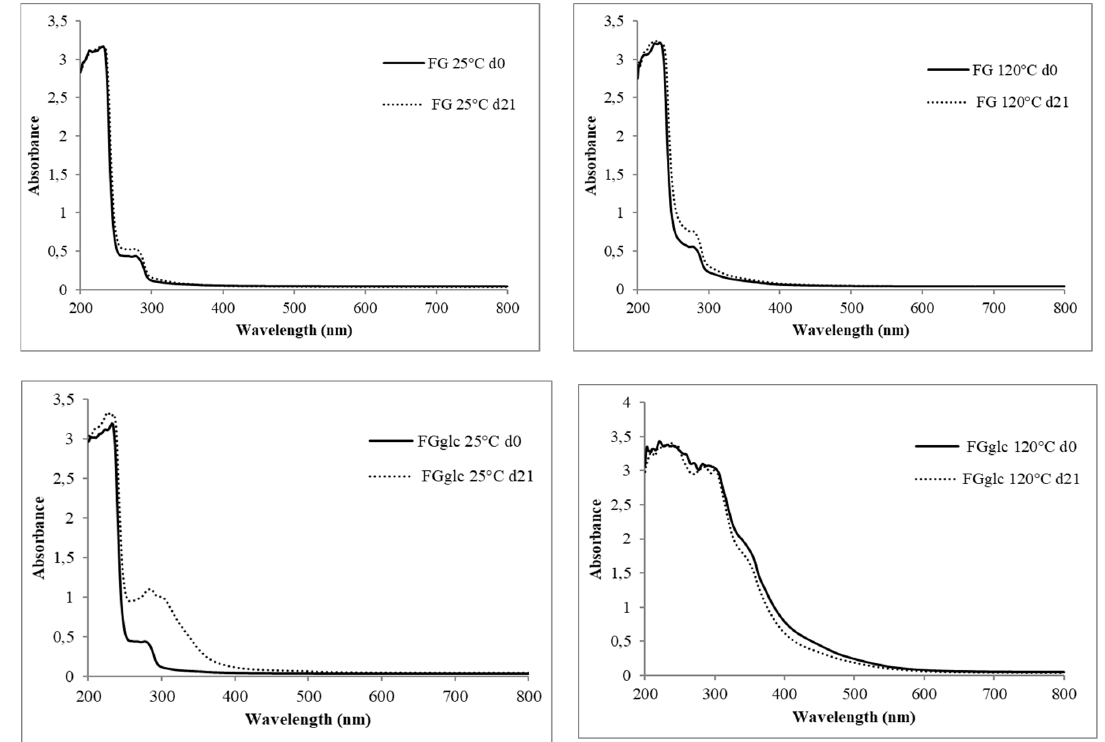
Figure 6. UV-vis spectra of the FG and FG-Glc pouches at day 0 and after application (day 21).